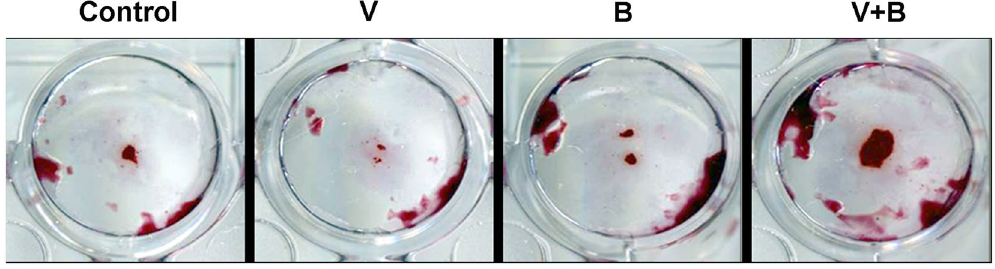
Figure 5. The formation of calcium nodule of the four groups by Alizarin Red S Staining.